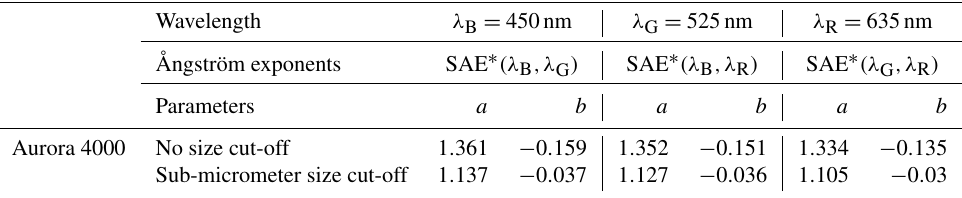
Table 3. Angular corrections for Aurora 4000 for the total scattering coefficient C 0 ◦ as a function of the scattering Ångström exponent: C 0 ◦ = a + b · SAE ∗ . For correction of the scattering coefficients for the blue wavelength ( λ B ), the scattering Ångström exponent calculated from uncorrected scattering coefficients of blue and green wavelengths ( λ B , λ G ) is used. At wavelength λ G and λ R , scattering Ångström exponents at the wavelength pairs ( λ B , λ R ) and ( λ G , λ R ) are used, respectively. Wavelength λ B = 450nm λ G = 525nm λ R = 635nm Ångström exponents SAE ∗ (λ B ,λ G